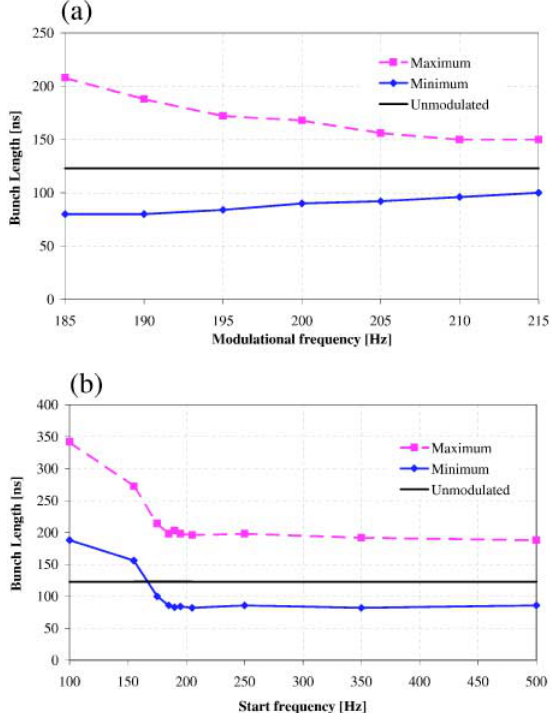
FIG. 6. (Color) (a) Measured bunch length vs modulation fre- quency. (b) Measured bunch length vs start frequency. The final modulation frequency is 190 Hz in all cases.